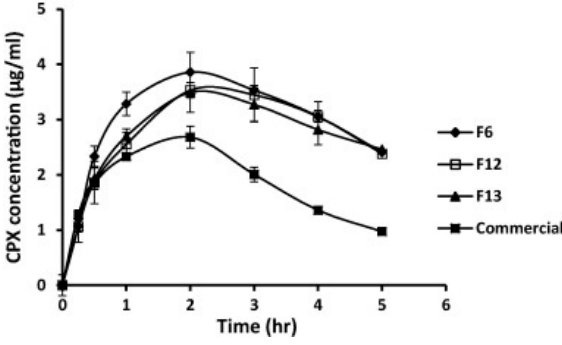
Figure 4. Concentration of ciprofloxacin in rabbit aqueous humor after the instillation of various liposomal formulations (F6, F12, and F13) as well as commercial eye drops [74]. F6, F12, F13